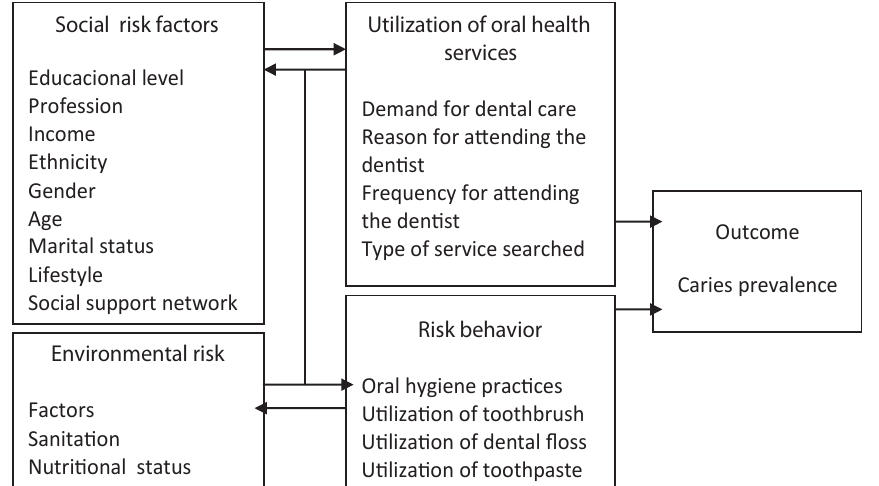
Figure 2 - Distal and proximal risk factors for analysis of dental caries. Adapted from Petersen, 2005.